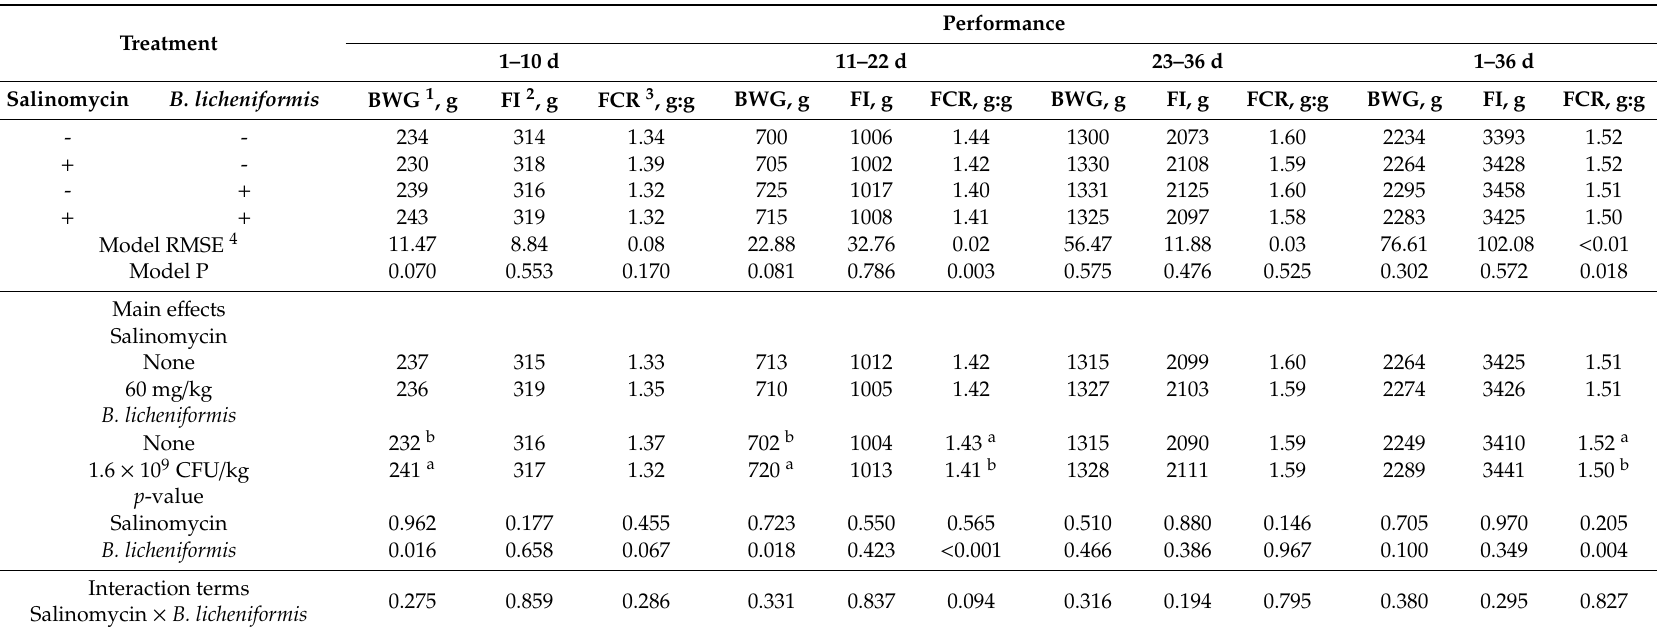
Table 2. E ff ect of Bacillus licheniformis addition alone or in combination with salinomycin on the growth performance of broiler chickens.